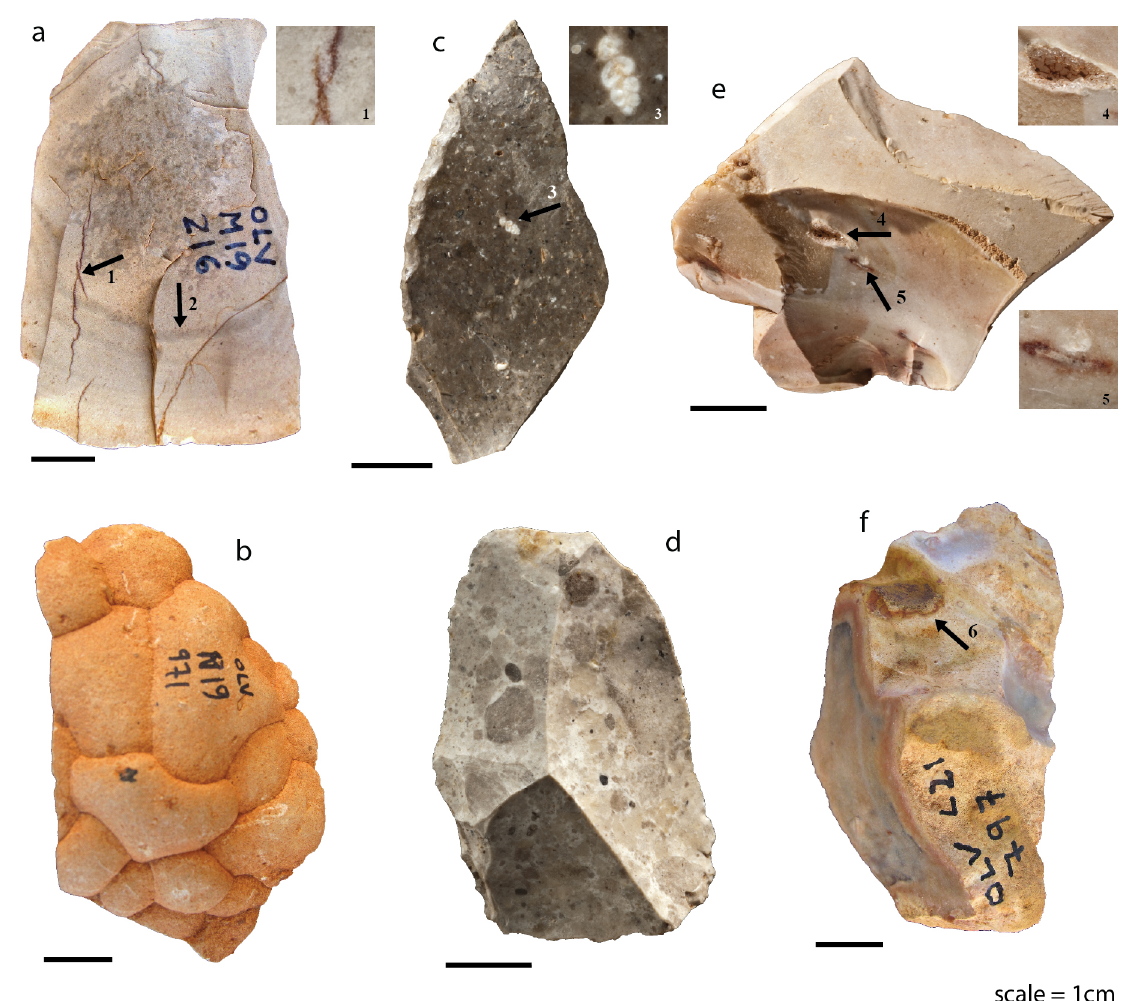
Figure 11. Flint’s distinctive features in the archeological sample: a. Bajocian flint. The iron filled diaclases pointed by arrow 1, and the concentric liesegang rings by arrow 2 are typical characteristics of flint type J2-2a (compare with Figure 3); b. botryoidal cortex of J2-3 type (Bajocian); c. and d. heterogenic “spotted like” texture of Oxfordian J3-3 type (compare with Figure 5, with a gastropod relict pointed by arrow 3; e. Upper Cenomanian flint with the siliceous reddish matrix turning rose and arrows pointing to a macroquartz filled geode (arrow 4) and a concentration of iron oxides (arrow 5) (compare with Figure 8); f. typical Upper Cenomanian flint in secondary position with rounded cortex impregnated by iron oxides (arrow 6). (Photos a., b. and f. by João Zilhão, b. to e. by José Paulo